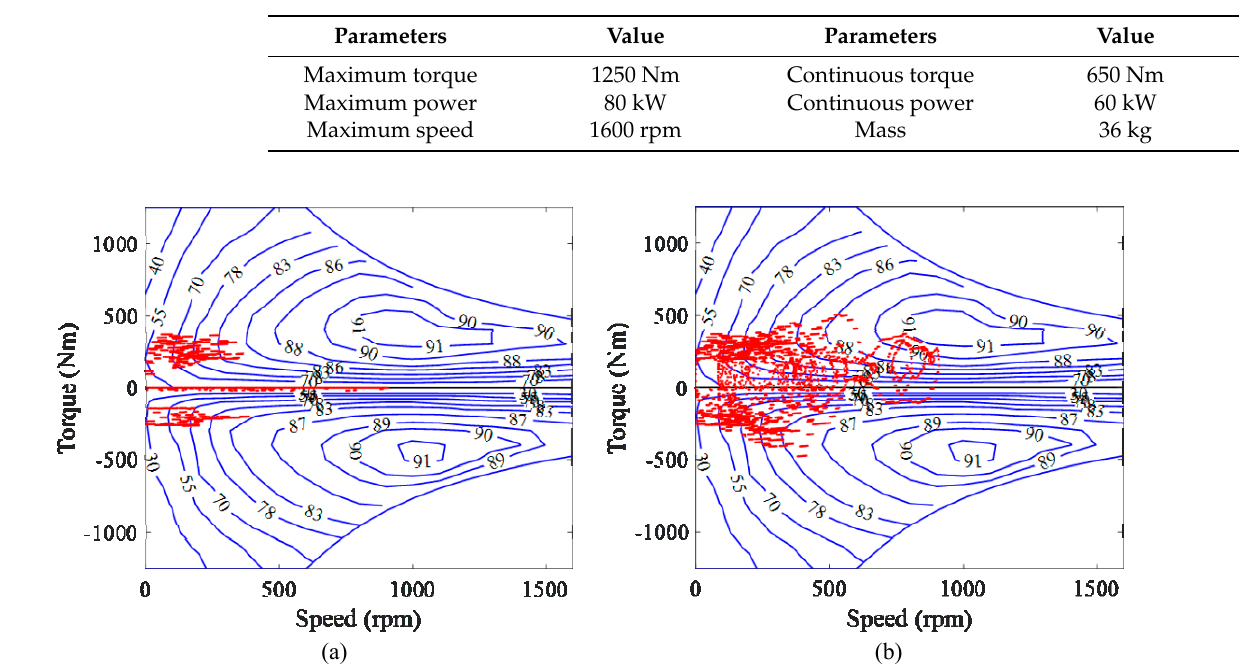
Figure 6. IEM working points. ( a ) Front IEM. ( b ) Rear IEM. Table 2. IEM